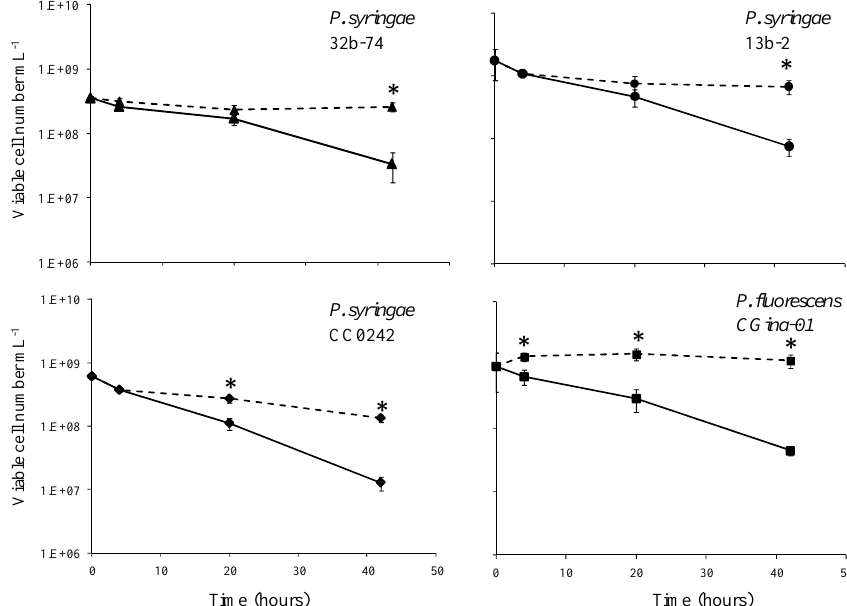
and O . The horizontal line corresponds to the lower limit 4 2 3 and O , where symbols 7 2 3